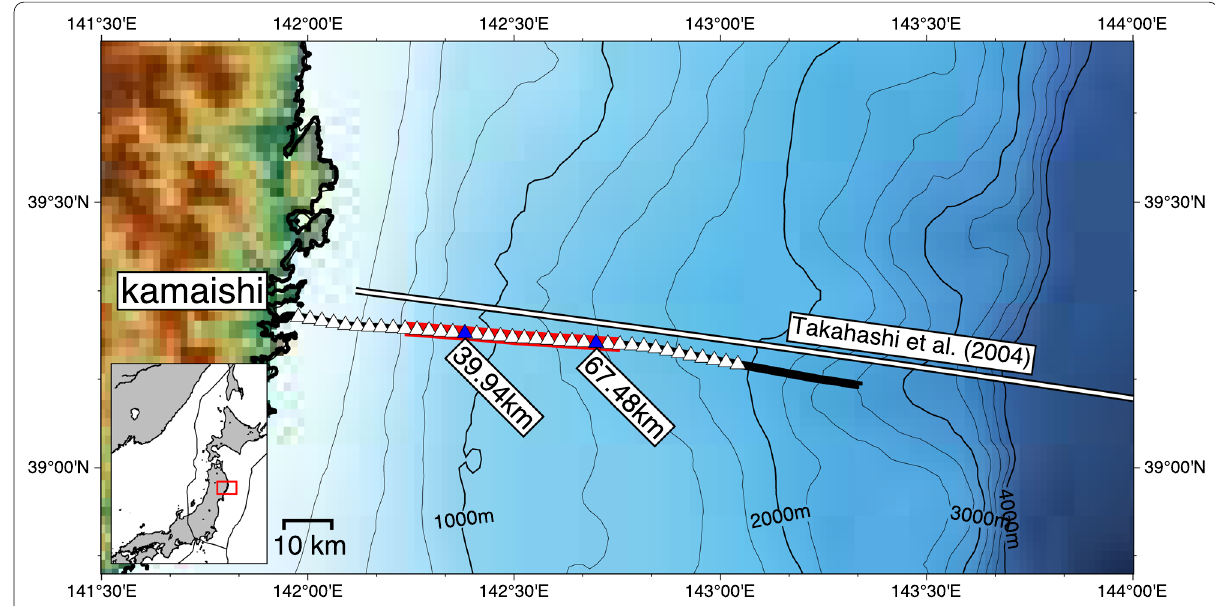
Fig. 1 Location of the seafloor cable containing optical fibers in the off-Sanriku region, Japan. Location of the optical seafloor cable in the off-Sanriku region, Japan. The black line indicates the route of the seafloor cable installed by the Earthquake Research Institute, the University of Tokyo. White triangles the indicate centers of the subarrays for calculation of the CCFs. Blue triangles indicate the centers at the distances from the coast of 39.94 and 67.48 km for the data processing demonstrated in Fig. 2 and 3. The red line shows a span of the estimated 2-D velocity profile shown in Fig. 4. Due to large incoherent noise near the coast and offshore areas, the spatial range of the present data processing was limited from 28 to 75 km from the coast. White lines indicate the survey lines of Takahashi et al.